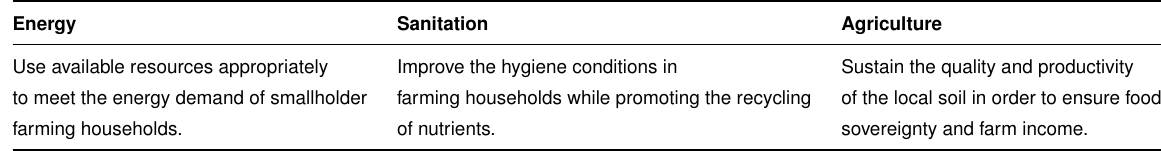
Table 2. Consented definition of the motivations behind the technology development of case study projects Energy